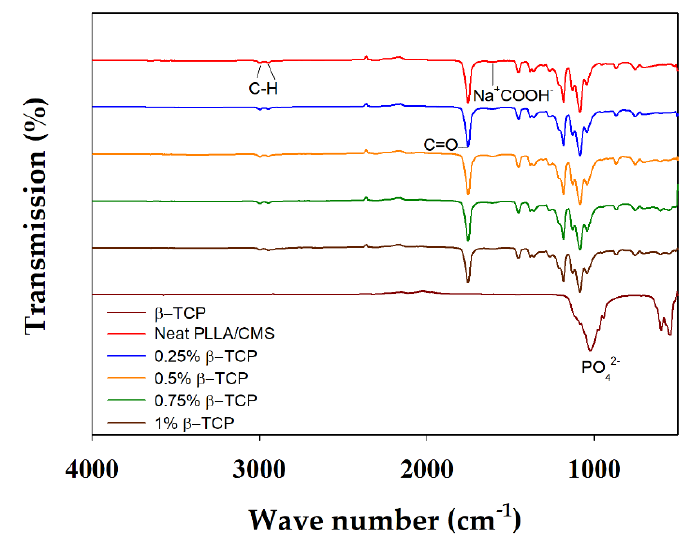
Figure 7. IR Spectrum of composite nanofibers with the different concentration of β -TCP.